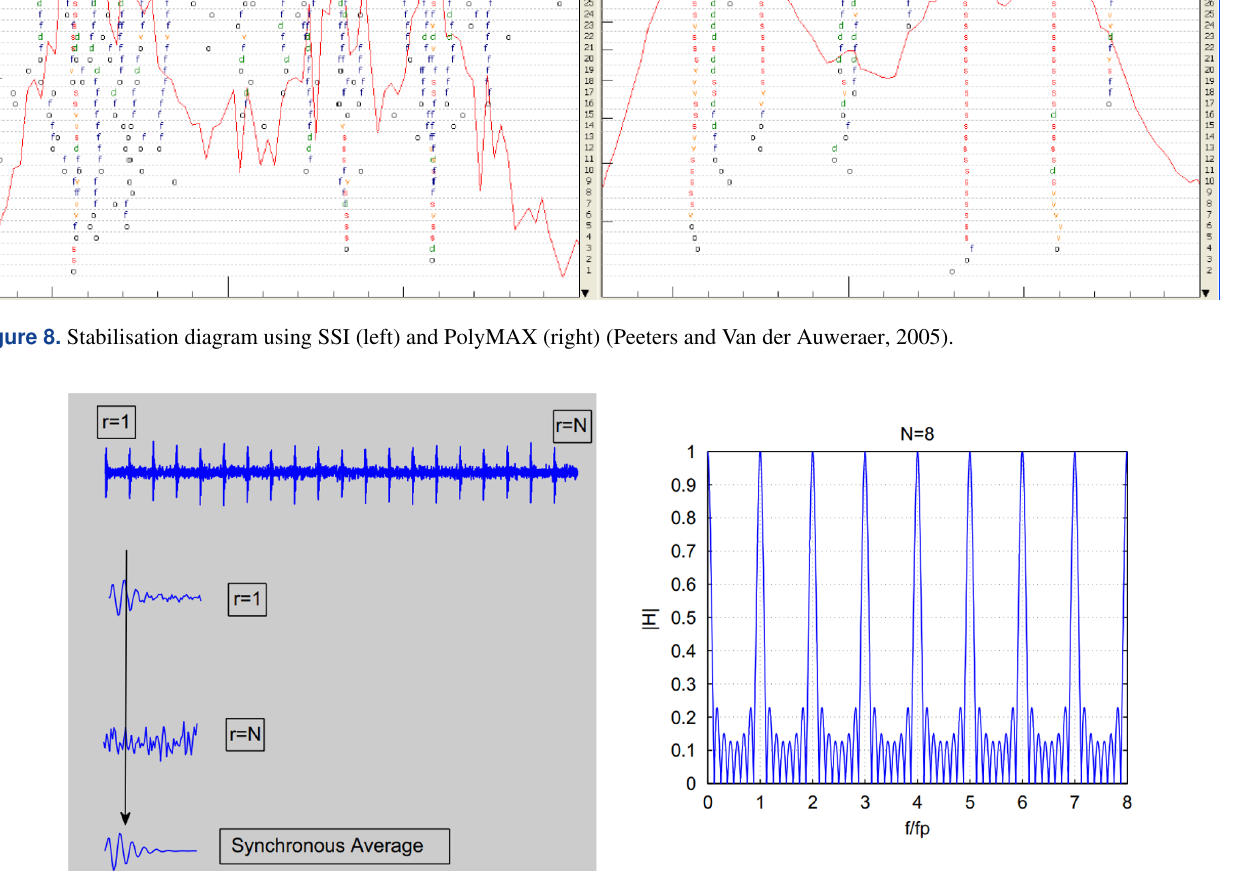
Figure 9. Impact of time synchronous averaging (TSA) in the angle domain (left) and the effective frequency response function of TSA (right) (Braun,